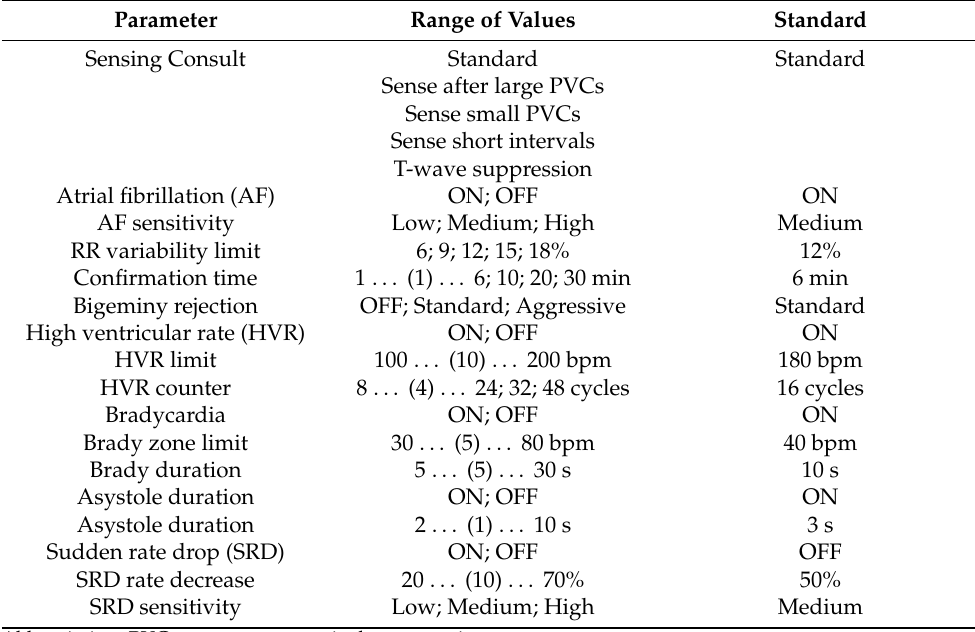
Table 1. Parameters of the BIOMONITOR III detection algorithms with a range of available values and standard settings. Parameter Range of Values